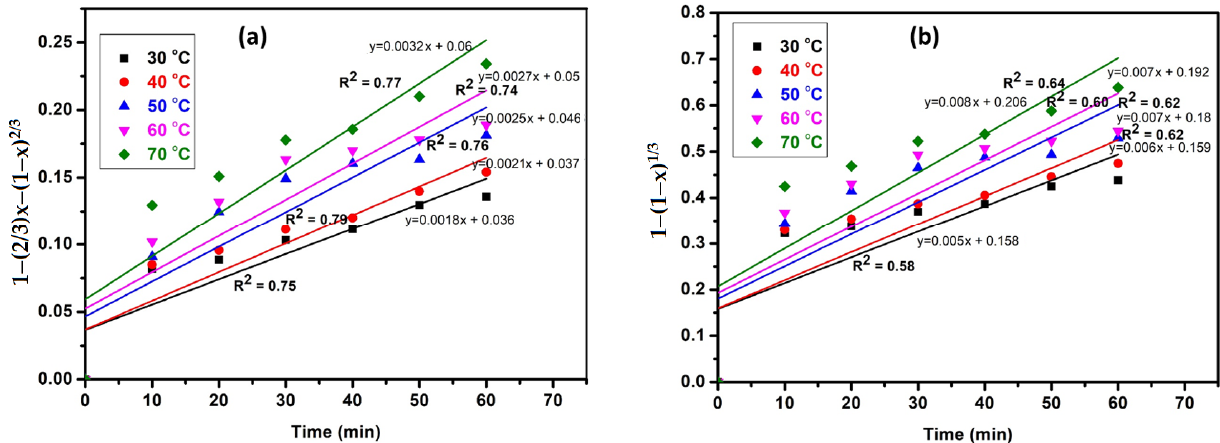
Figure 8. ( a ) Diffusion-controlled and ( b ) surface reaction-controlled models for leaching of gold (temp. 30 to 70 °C).